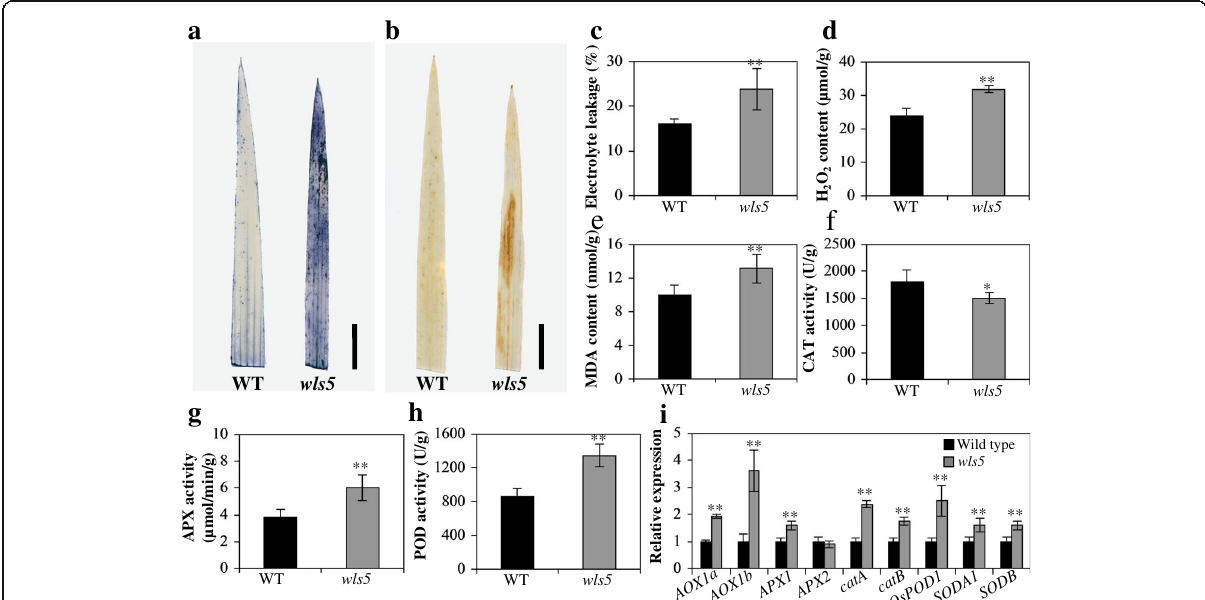
Fig. 5 ROS accumulation in wild-type (WT) and wls5 plants. a , b NBT ( a ) and DAB ( b ) staining of leaves from WT ( ‘ 93 – 11 ’ ) and wls5 plants at seedling stage. Bars = 1 cm. c - h Statistical analysis of electrolyte leakage ( c ), H 2 O 2 content ( d ), MDA content ( e ), CAT activity ( f ), APX activity ( g ) and POD activity ( h ) in leaves of WT and wls5 plants. Mean ± SD of five independent replicates, ** P < 0.01, * P < 0.05 (Student ’ s t- test). i Relative expression levels of ROS detoxification related genes in WT and wls5 plants; mean ± SD of three independent replicates. ** P < 0.01 (Student ’ s t-